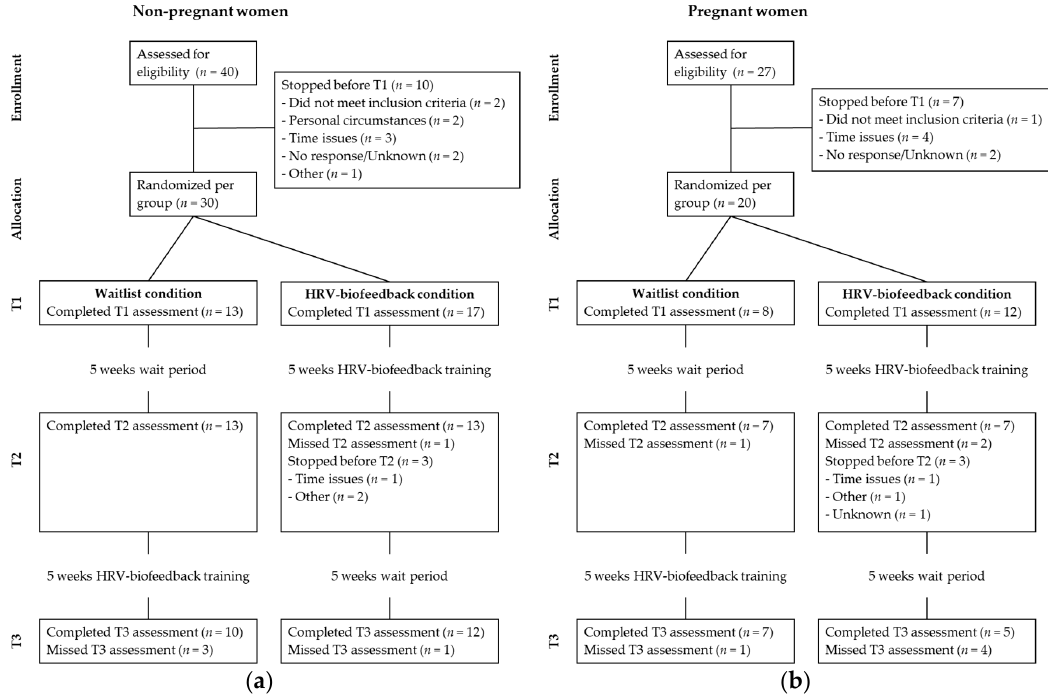
Figure 1. CONSORT flow diagram of participant flow through the study of: ( a ) non-pregnant participants; ( b ) and pregnant participants.